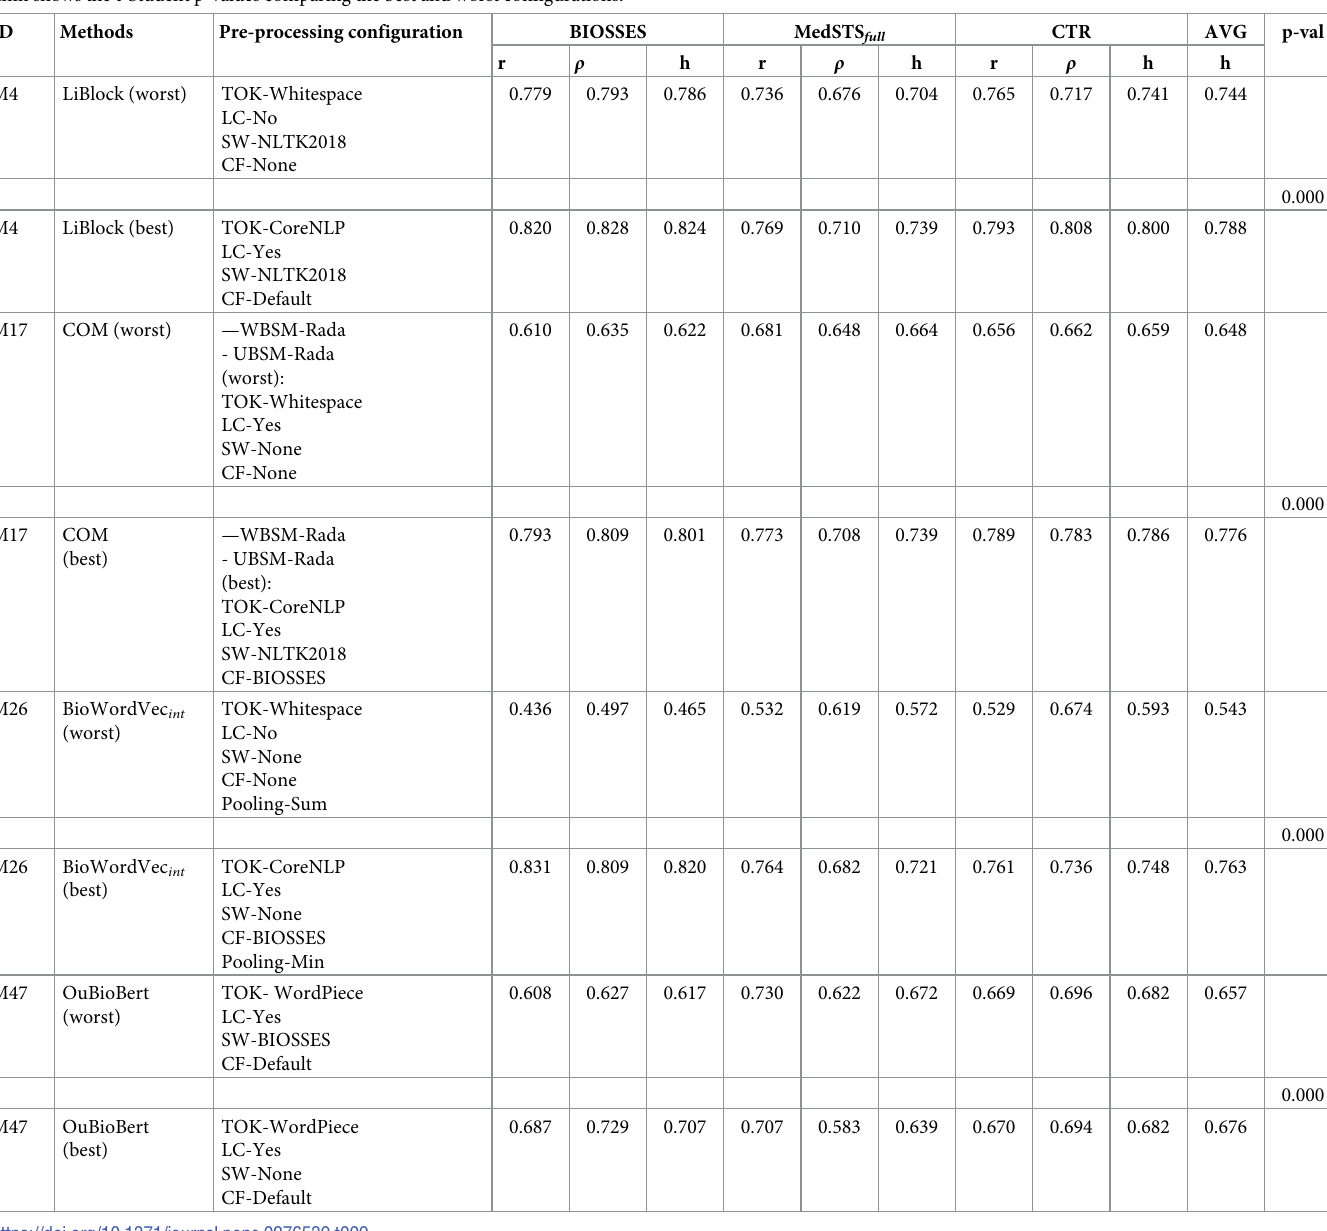
Table 9. Comparison of results for the “best” and the “worst” pre-processing configurations for the best-performing methods of each family in Table 8. The last col- umn shows the t-Student p-values comparing the best and worst configurations.